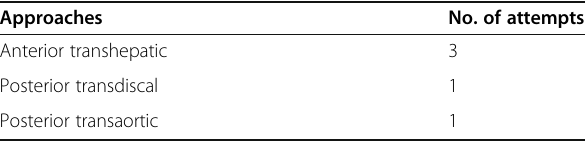
Table 2 Different approaches and no. of attempts we did in our study for the stellate ganglion